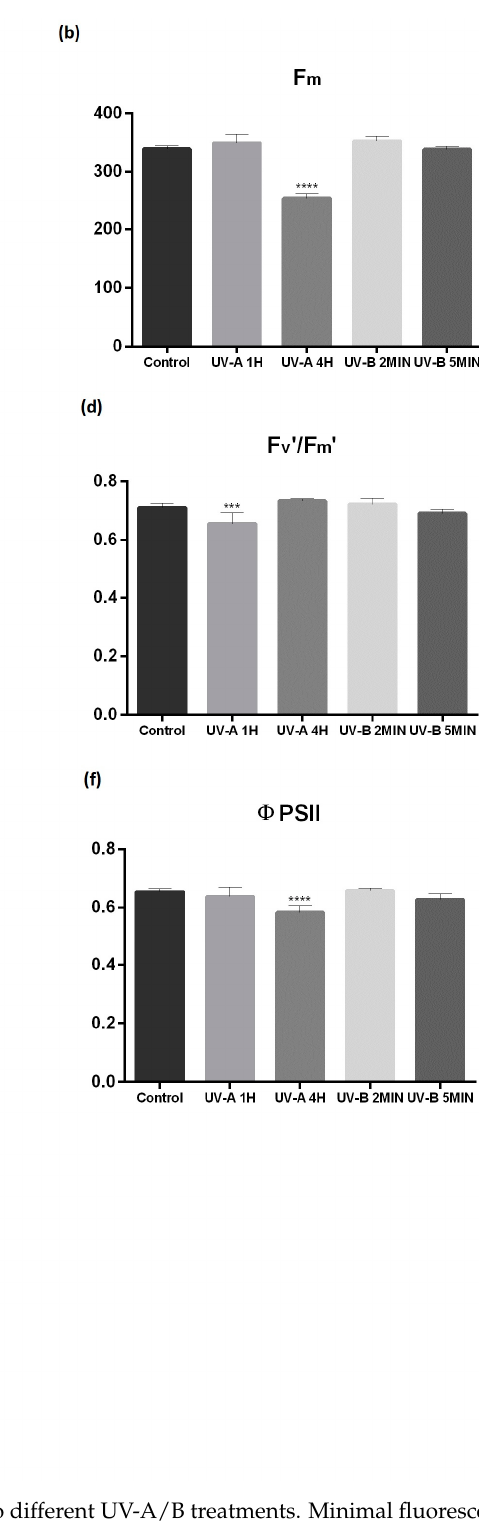
Figure 1. Chlorophyll a fluorescence after 30 d of exposure to different UV-A/B treatments. Minimal fluorescence yield of dark-adapted leaves with all PSII centers closed, F 0 ( a ); maximum fluorescence of dark-adapted leaves with all PSII centers closed, Fm ( b ); maximum quantum efficiency of PSII, Fv/Fm ( c ); PSII maximum efficiency in saturating light if all reaction centers are open, Fv’/Fm’ ( d ); photochemical quenching, qP ( e ); effective efficiency of PSII, Φ PSII ( f ) and non-photochemical quenching, NPQ ( g ). Within each parameter, *, *** and **** mean significant differences for p < 0.05, 0.01, 0.001 and 0.0001, respectively. Values are expressed as the mean and standard deviation (n =